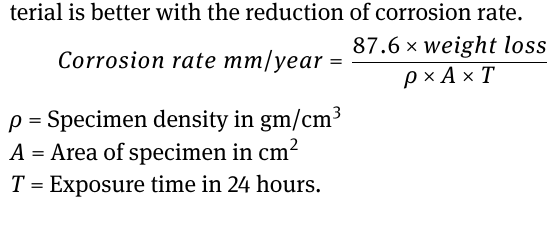
terial is better with the reduction of corrosion